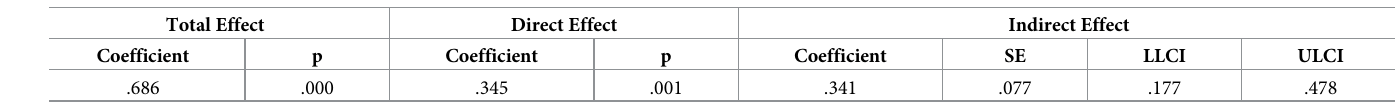
Table 6. Mediation test